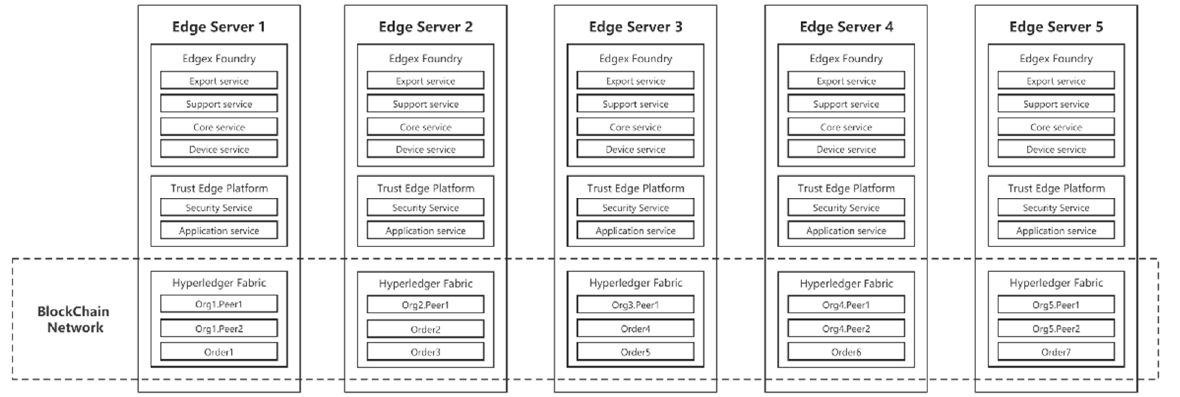
Figure 8. Schematic diagram of experimental equipment organization scheme.